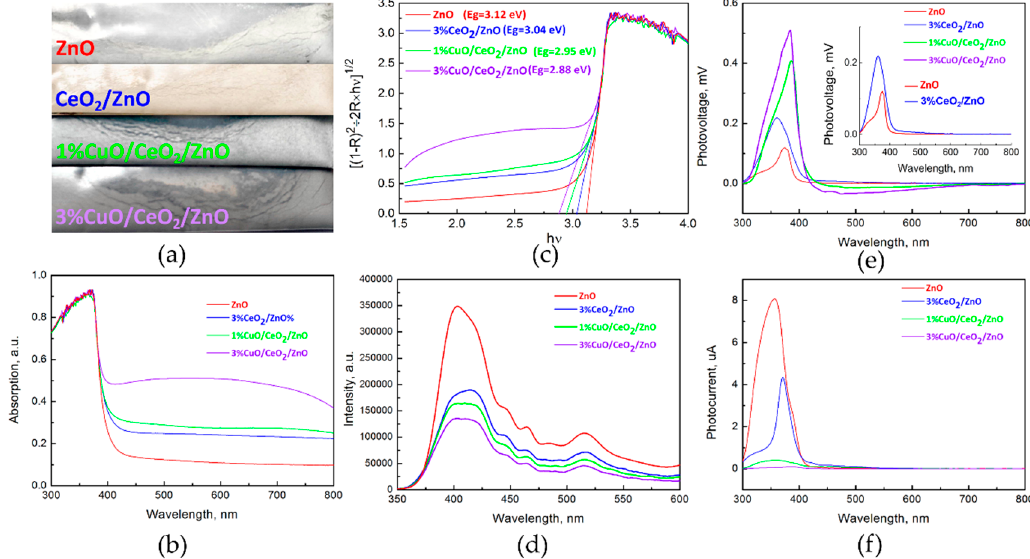
Figure 3. ( a ) Appearances of the as-synthesized samples. ( b ) UV-vis absorption spectra of the as-synthesized samples. ( c ) Band-gap widths calculated from Kubelka-Munk function. ( d ) Photoluminescence (PL) spectra of the as-synthesized samples. ( e ) Surface photovoltage (SPV) and ( f ) surface photocurrent (SPC) spectra of the samples.